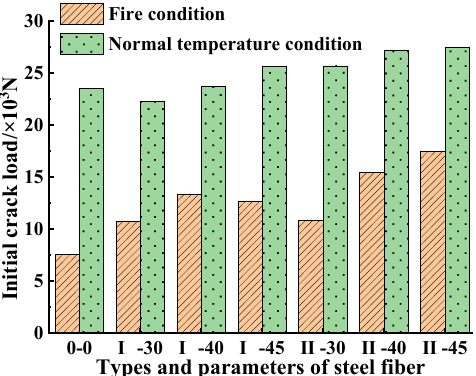
Figure 11. Initial crack flexural strength before and post fire.